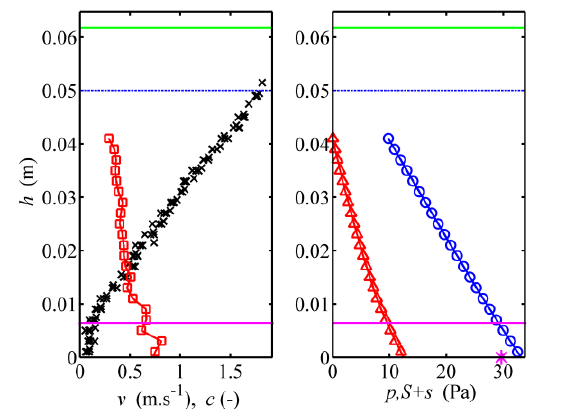
Fig. 3. Distributions in layered flow of FA60-mixture (bed Shields parameter = 0.2). Left plot - measured distribution of volumetric concentration and velocity. Right plot – calculated solids normal stress and total shear stress. Legend: black x – velocity profile, red square – concentration profile, from top to bottom: green line - water surface, blue line – top of transport layer, magenta line - top of dense layer; right plot: red triangle – normal stress, blue circle - total shear stress, magenta star – bed shear stress computed from measured integral data